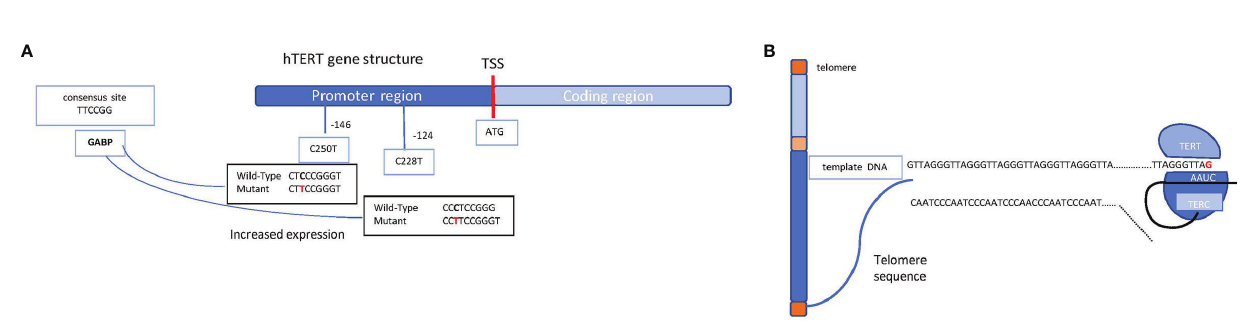
FIGURE 3 | Schematic representation of the hTERT gene structure and the telomerase complex. (A) Schematic mechanism of a chromosome (telomeres in orange, short arm in light blue, long arm in blue, and centromere in yellow) and the molecular mechanism through which TERT enzyme, supported by TERC, ensure the telomere length. (B) hTERT gene promoter region (in blue) and coding region (in light blue) are shown. The transcription start site (TSS) is indicated as a red bar; on the promoter region, the most common mutations which lead to an increased expression of the gene are shown (the indicated positions refer to the TSS). Shown on the left, in the light blue box, is the consensus sequence which takes place because of the single mutation, allowing the binding of the transcription factor GABP on the